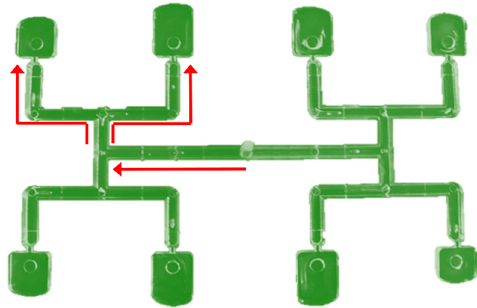
Figure 1. Filling imbalance in geometrically balanced injection molds.